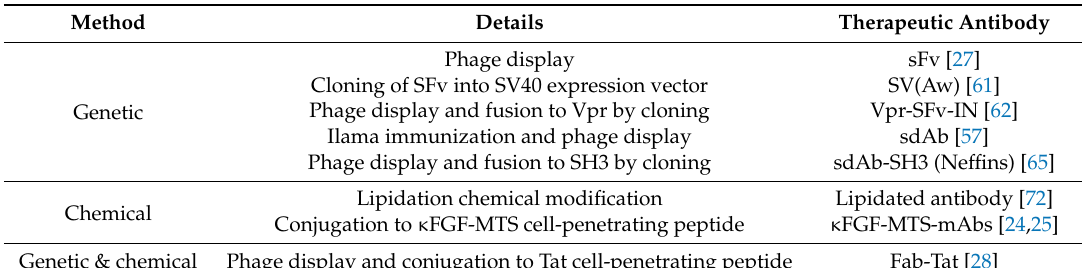
Table 2. Technologies of cell-penetrating antiviral antibodies development in the past twenty